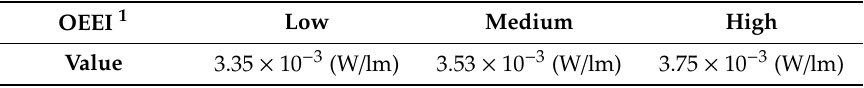
Figure 10. Visible light spectra of liquid crystal displays (LCDs) with low, medium, and high ocular energy exposure index (OEEI) values. Table 1. Liquid crystal displays (LCDs) with low, medium, and high ocular energy exposure index (OEEI) values used in this